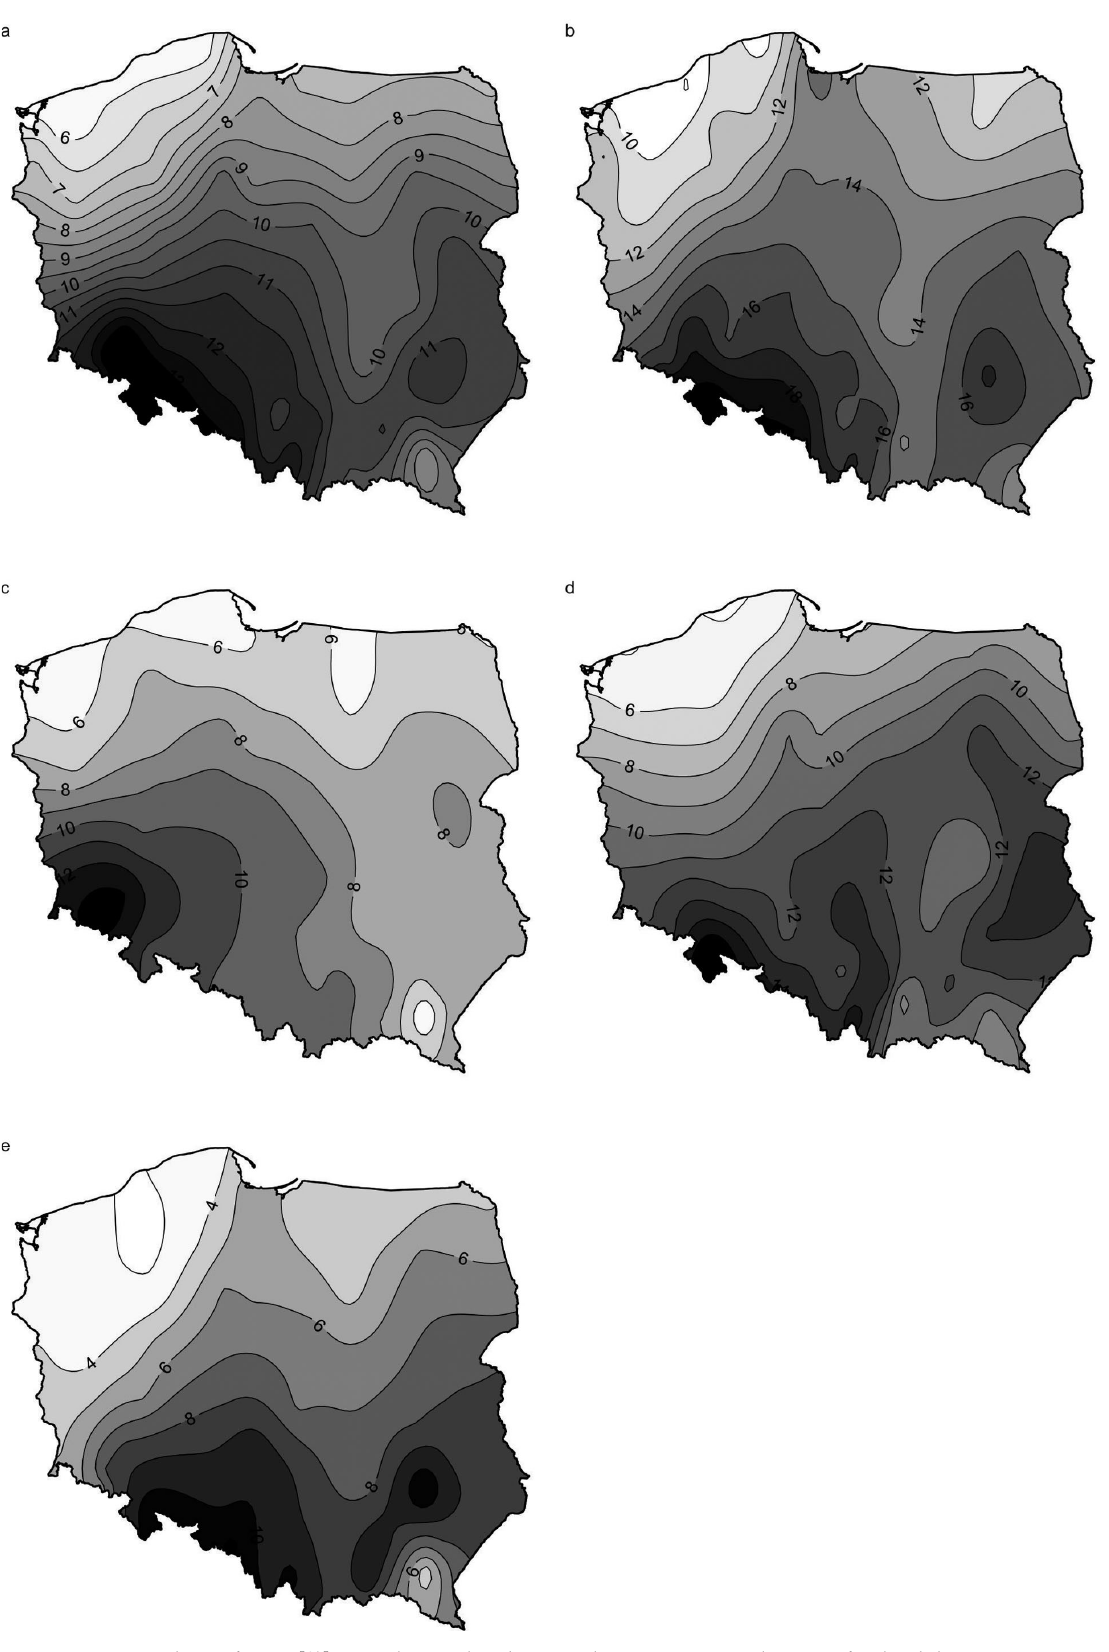
Fig. 4. Average share of MCP [%] in total annual and seasonal precipitation in the area of Poland during 1958–2008 a – year, b – spring, c – summer, d – autumn, e –